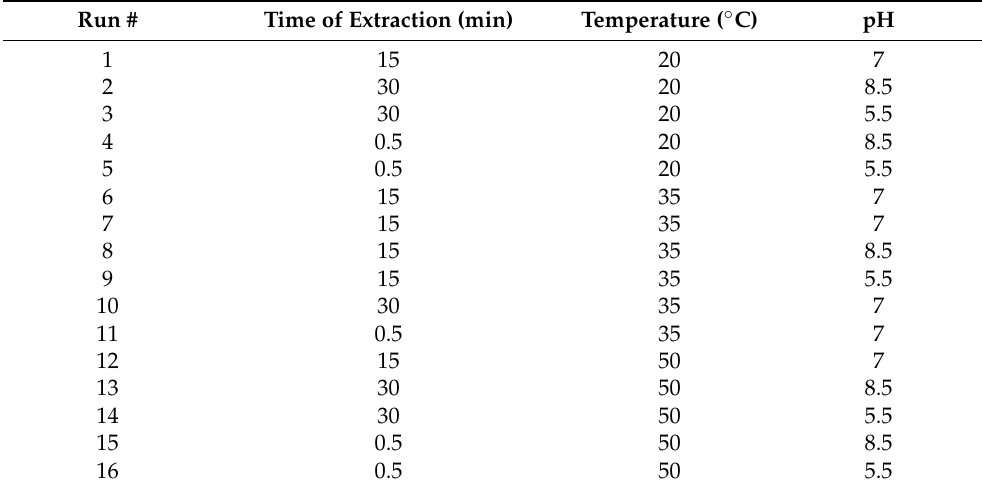
Table 1. Conditions of time of extraction (min), temperature ( ◦ C) and pH for the 16 experiments included in the response surface